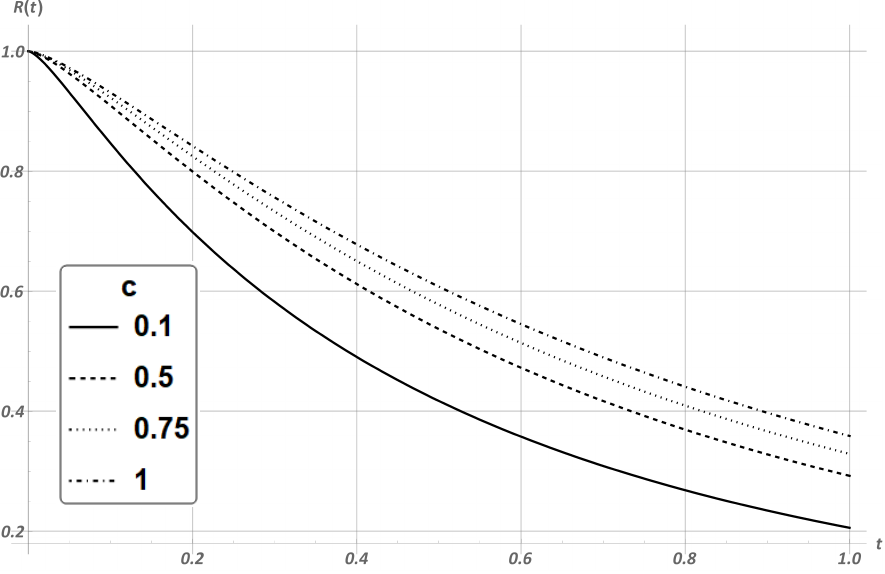
Figure 3. Reliability function with GW distribution of the components’ lifetime with v =